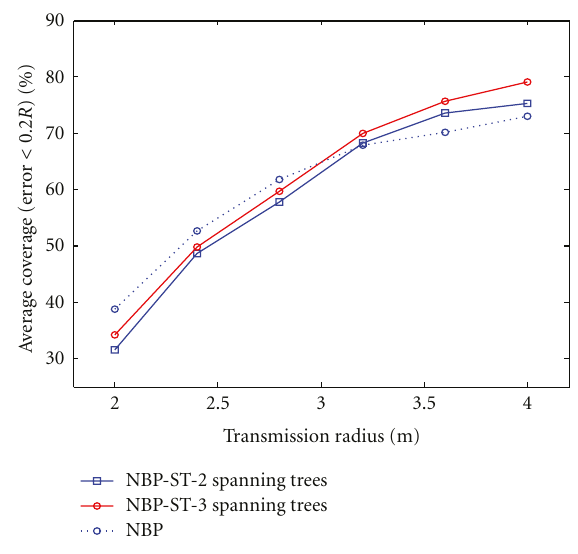
Figure 12: Comparison of